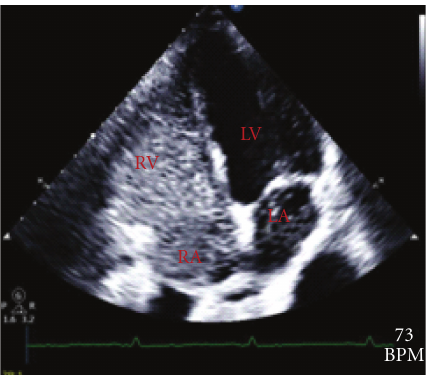
Figure 2: Contrast-enhanced echocardiography showing the appearance of microbubbles in the left atrium 6 cycles after they first appeared in the